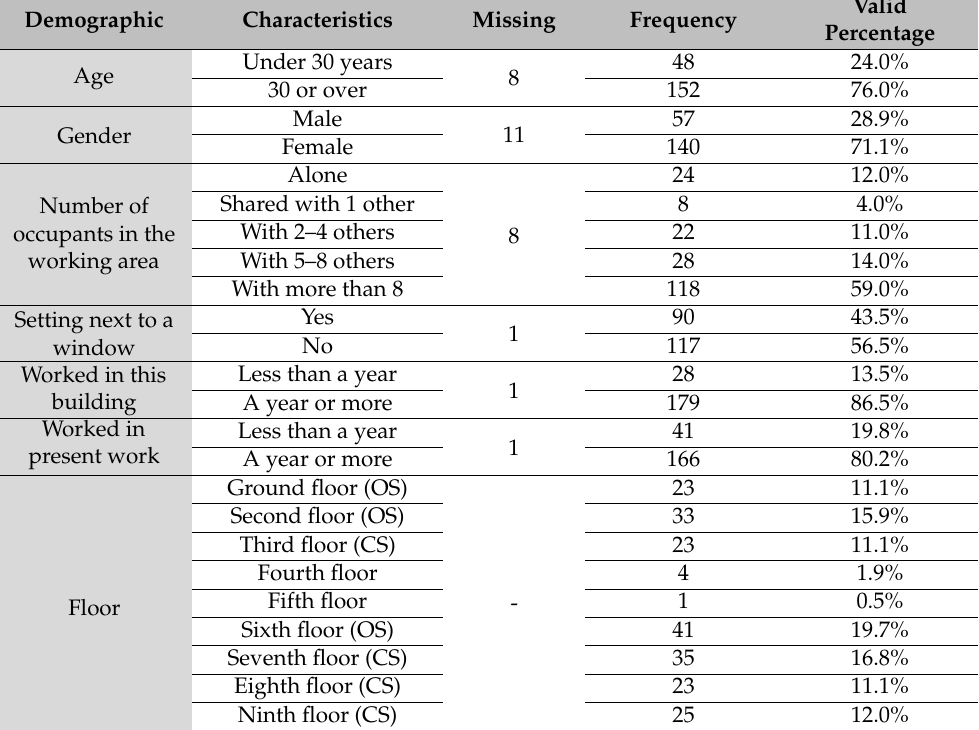
Table 2. Demographic characteristics of the respondents (all